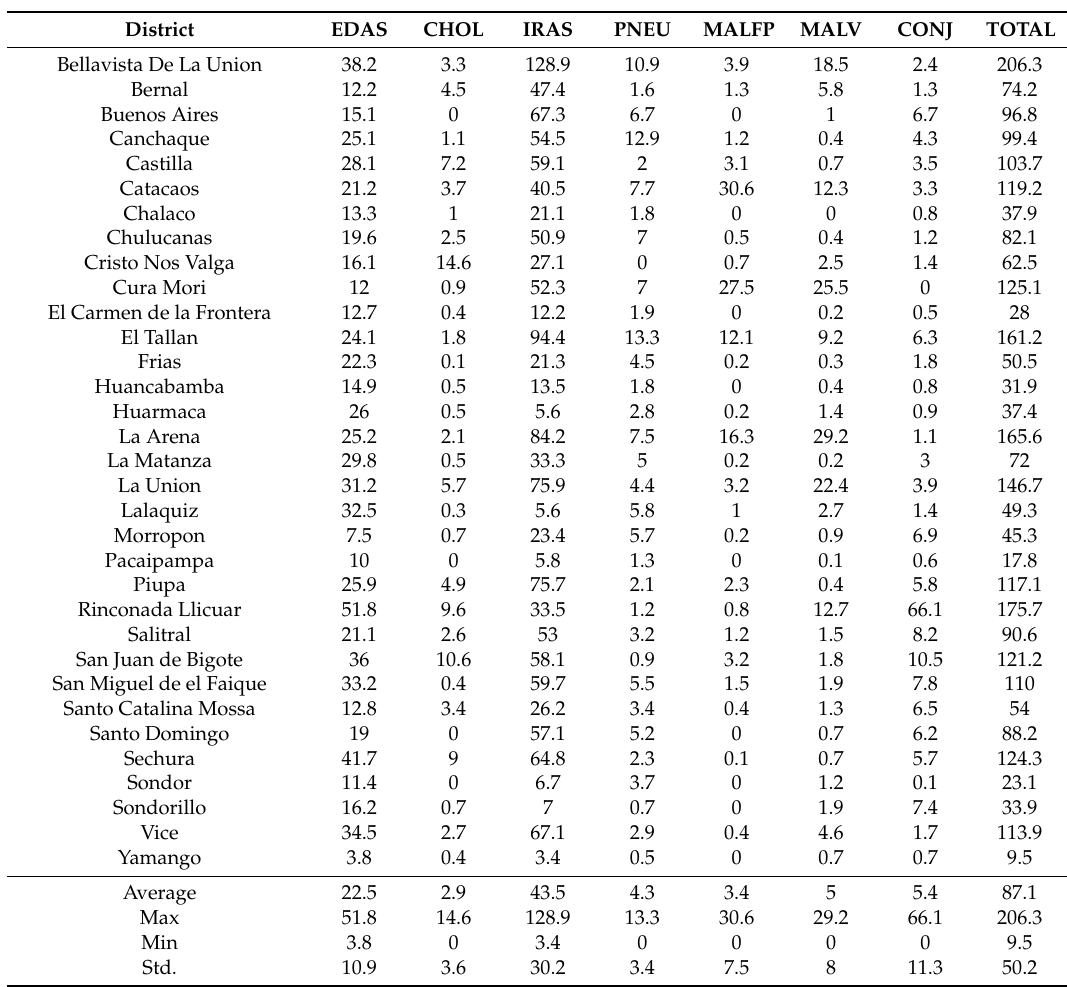
Table 2. Disease incidence rate (per 1000 population) by district (season). District EDAS CHOL IRAS PNEU MALFP MALV CONJ Bellavista De La